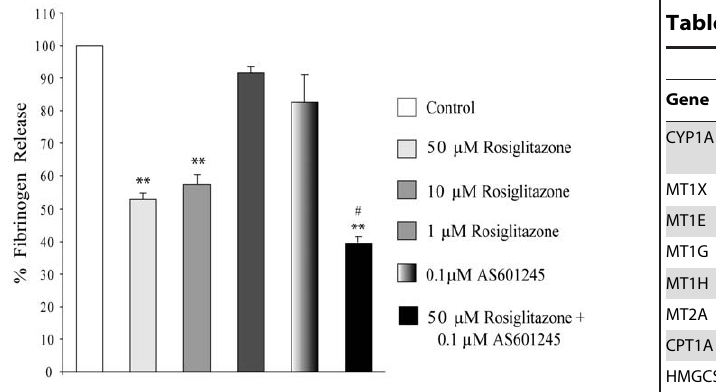
Figure 5. Fibrinogen release. Fibrinogen release in CaCo-2 cells exposed to different concentration (1-10-50 m M) of rosiglitazone, 0.1 m M AS601245 or both substances (50 m M rosiglitazone and 0.1 m M AS601245). Data are expressed as percentage of fibrinogen release with respect to the control value and is the mean 6 SD of 3 separate experiments. Variance analysis: ** p , 0.01 vs control, # p , 0.05 vs rosiglitazone.